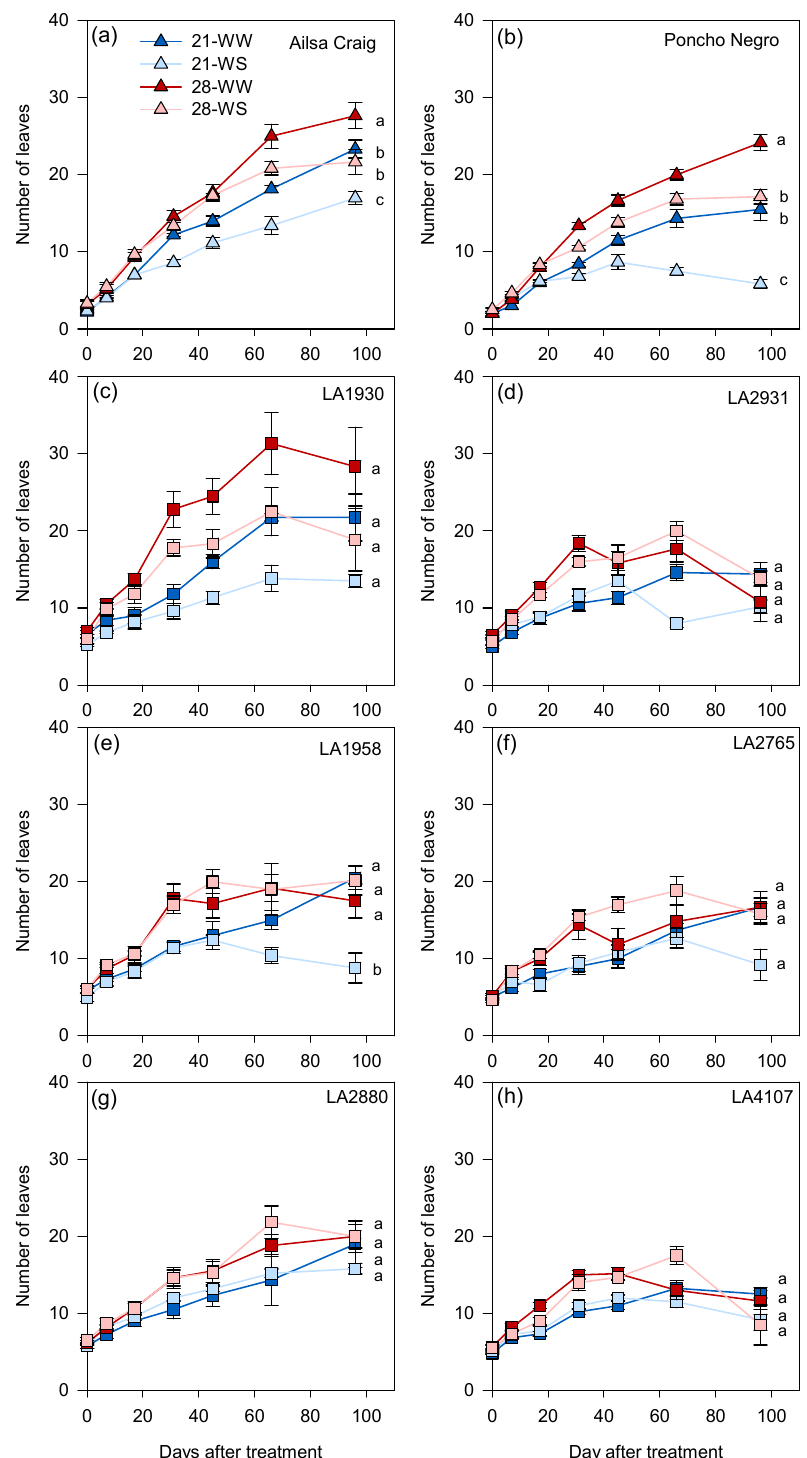
Figure 3. Effect of temperature and water stress on the leaf production of ( a , b ) S. lycopersicum cultivars and ( c – h ) S. chilense populations. Plants were grown at 21 °C under well-watered (21-WW) and water-stressed (21-WS) conditions or at 28 °C under well-watered (28-WW) and water-stressed (28-WS) conditions; triangle: S. lycopersicum , square: S. chilense . Treatments followed by different letters are significantly different at p < 0.05 for the same accession at the end of the experiment. Data ± SE.